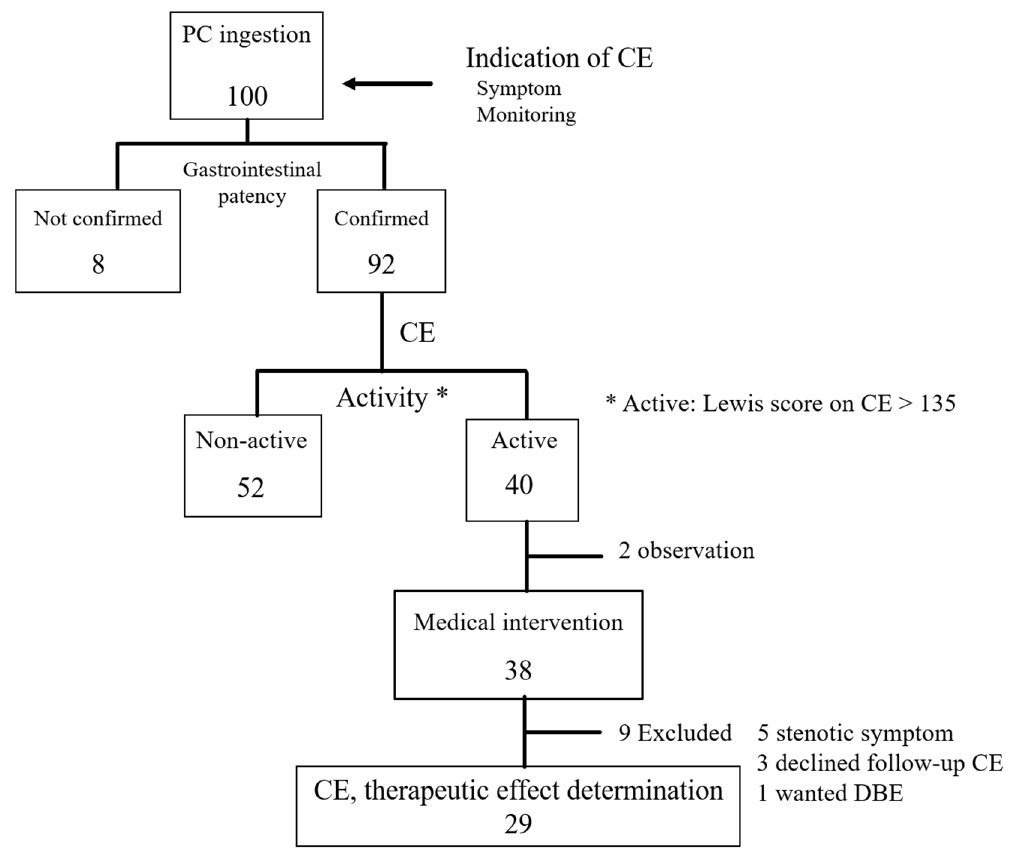
Figure 2. Flow chart of present study. Abbreviations PC, patency capsule; CE, capsule endoscopy; DBE, double balloon enteroscopy.